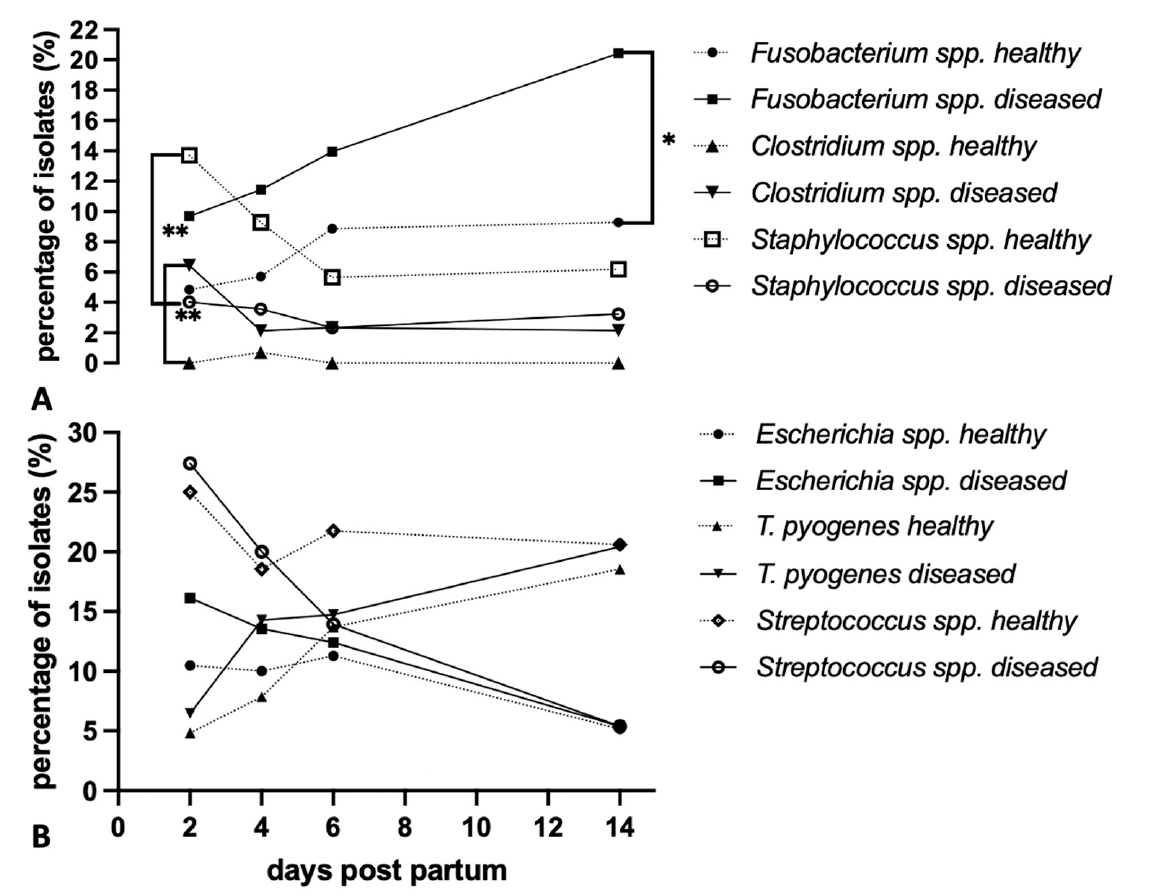
Figure 6. ( A ) Percentage of isolates of selected genera that were significantly more abundant in healthy animals (n = 12; Staphylococcus spp.) or in diseased animals (n = 10; Fusobacteria spp., Clostridium spp.) over the entire sampling period (day 2, 4, 6, 14 p.p.); Chi-squared test comparison between healthy and diseased cows per sampling time point and genus: * p < 0.05, ** p < 0.01. ( B ) Percentage of isolates of selected genera that showed no significant differences between healthy and diseased animals over the combined sampling period but were among the most frequently isolated genera.